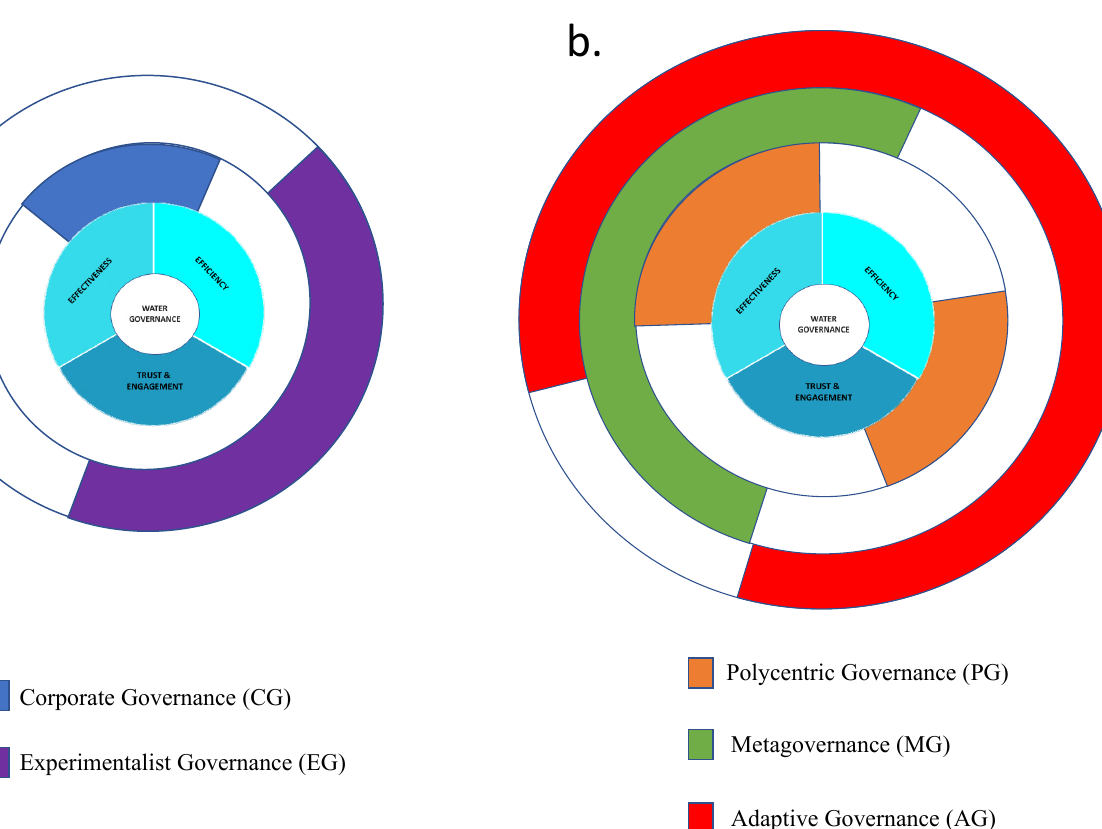
Figure 2. Two possible combinations of governance approaches to address specific WS issues. ( a ) combination of CG and EG; ( b ) combination of PG, MG and AG. Source: adapted from the OECD